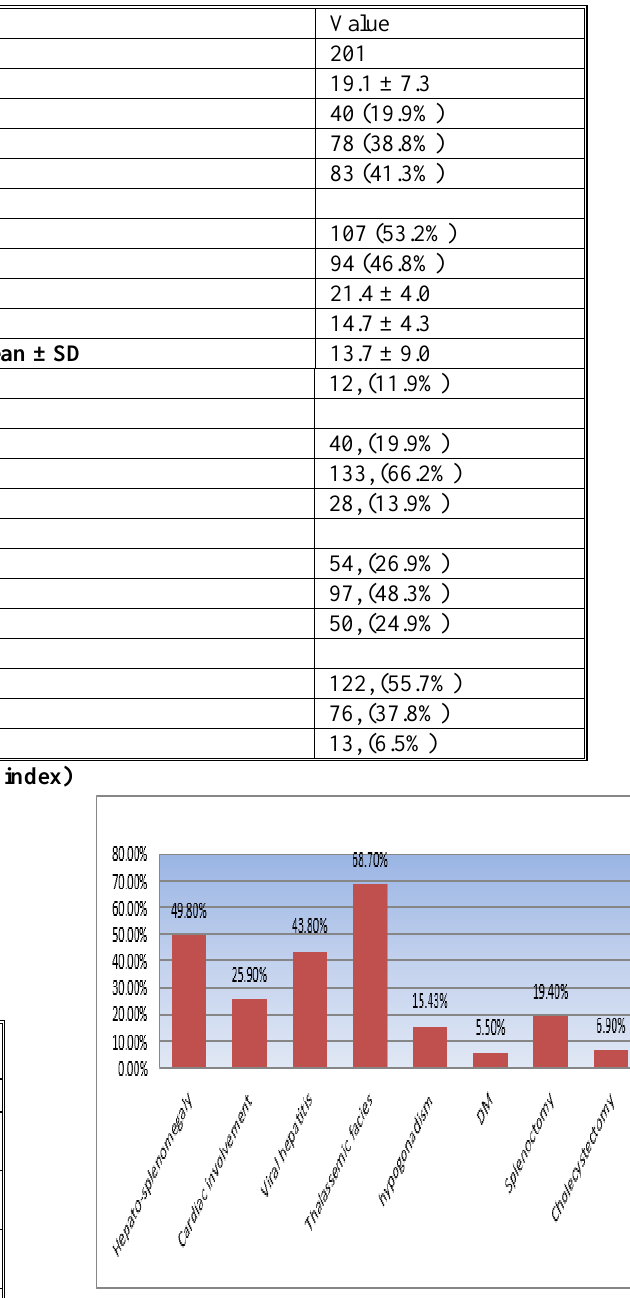
Figure (1) percentages of complications in thalassemia major